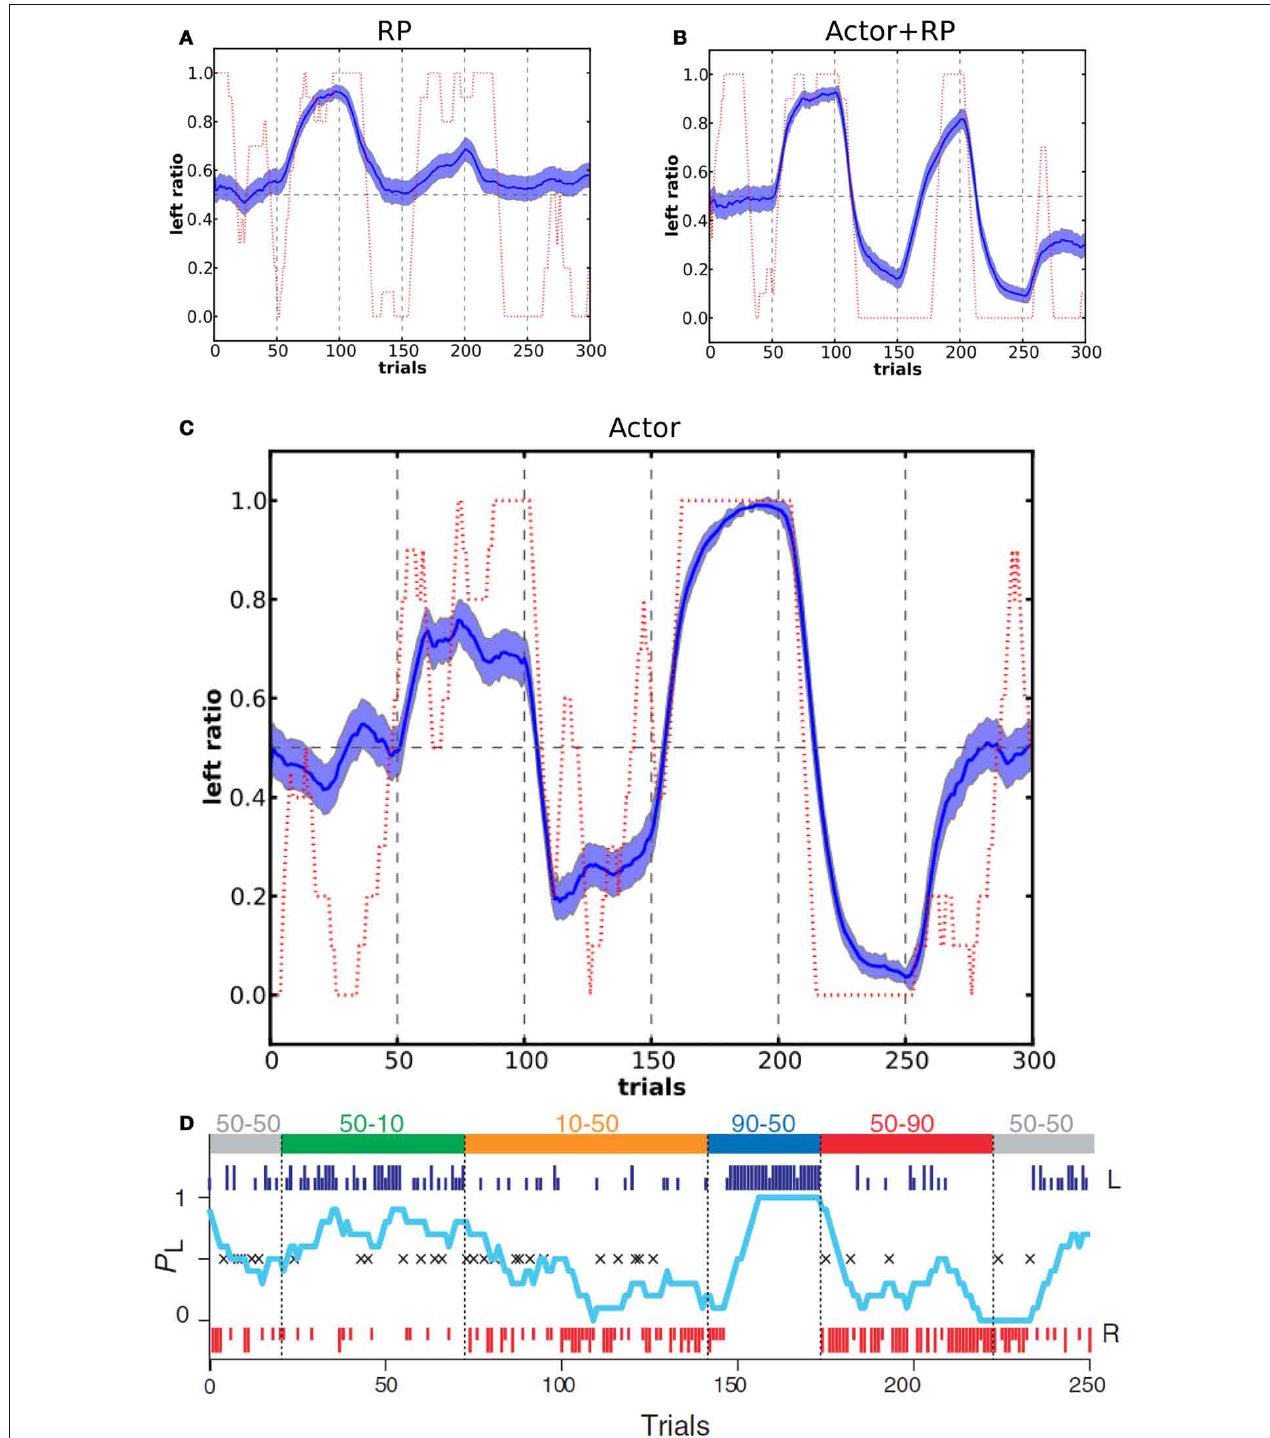
FIGURE 9 | Action selection dynamics in a two-choice task with changing reward schedule. At the top of panel D are shown two values for each block, the first one is P(r|left) and the second one is P(r|right). In our simulations, each block consisted of 50 trials (blue dashed vertical lines). Panel D shows results reproduced from the experimental study on a monkey